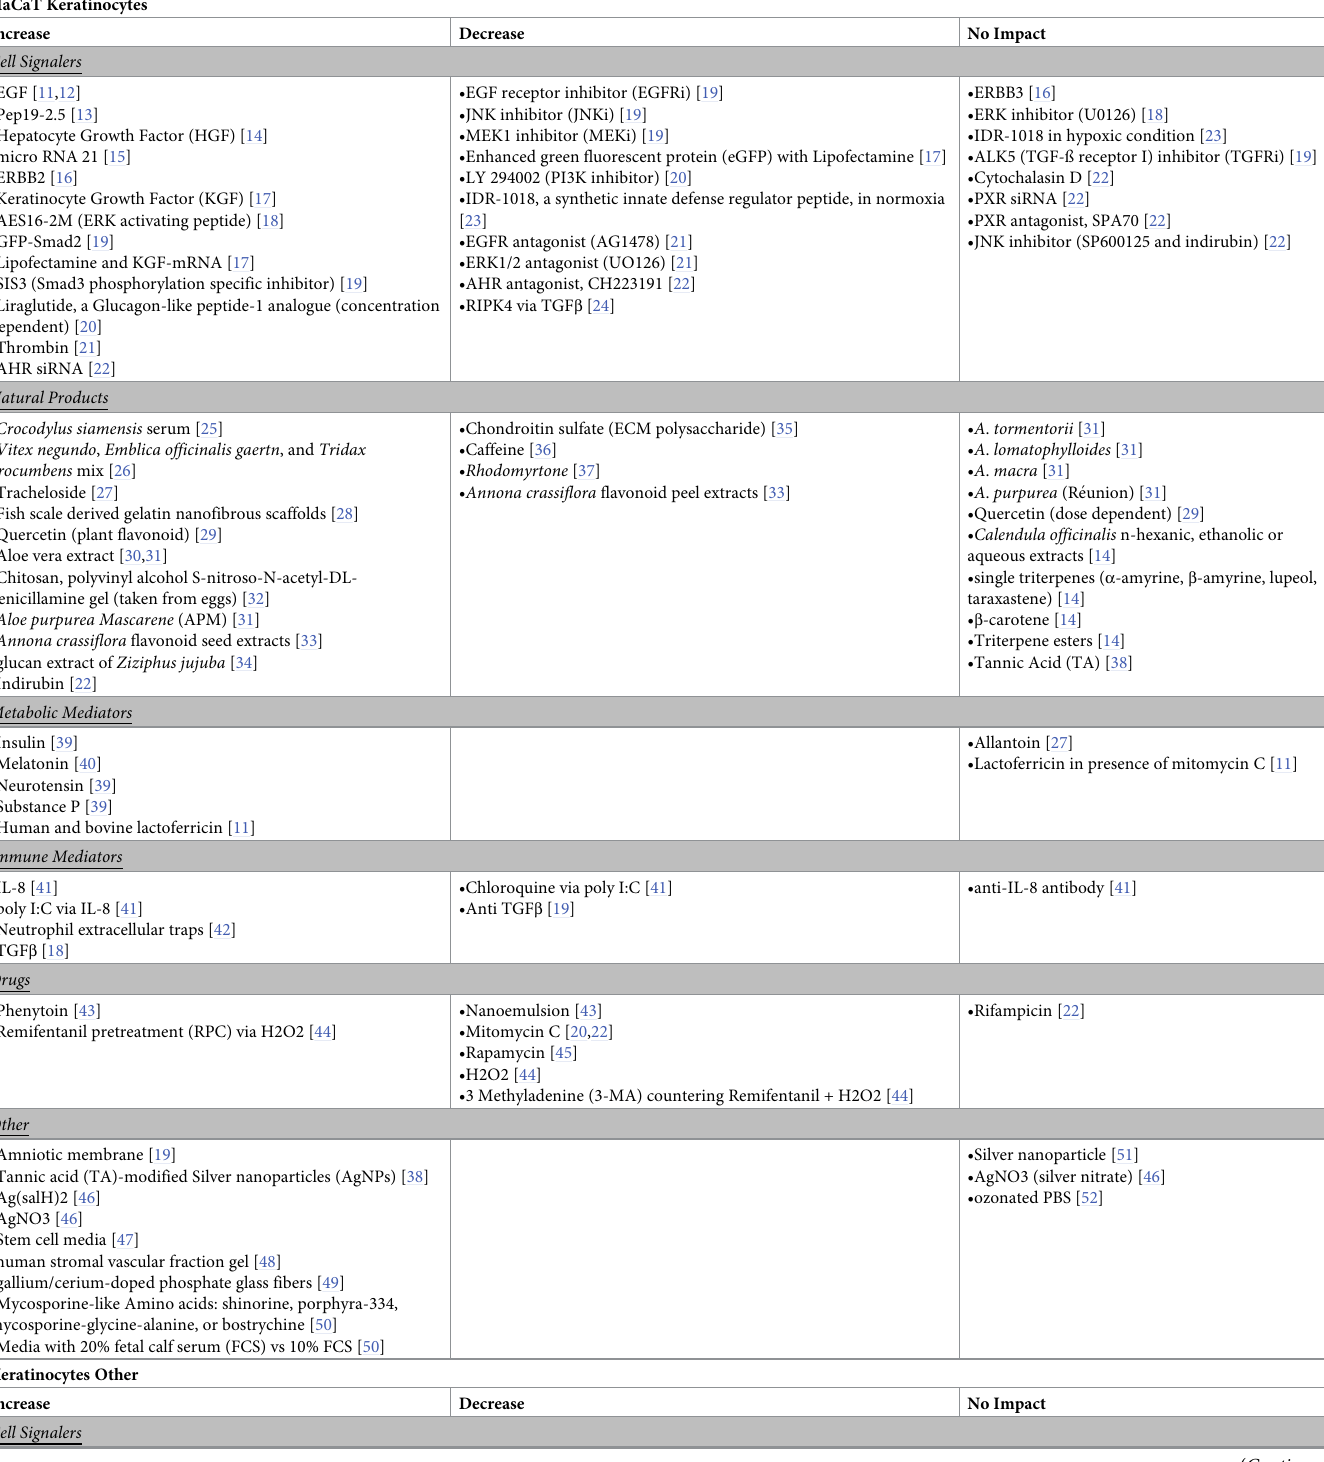
Table 1. Effect of different stimuli on scratch assay in keratinocytes, fibroblasts, and epithelial cells. Migration rate of scratch assay in response to cell signalers, natu- ral products, metabolic mediators, immune mediators, drugs, and other stimuli. HaCaT